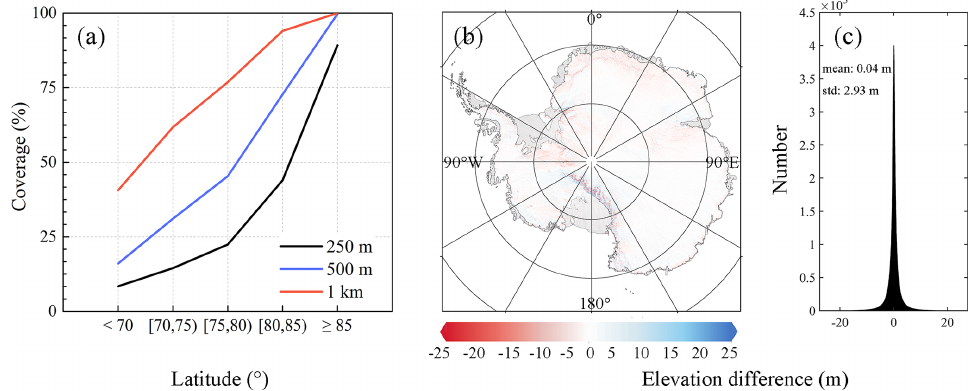
Figure 4. (a) Spatial coverage of observed grid cells in the five latitude ranges when three spatial resolutions, i.e. 250m (black), 500m (blue) and 1km (red), are applied. (b) Map of the elevation difference of DEMs at the resolutions of 1km and 500m. (c) Histograms of the elevation difference of DEMs at the resolutions of 1km and 500m, the average and standard deviation values are also